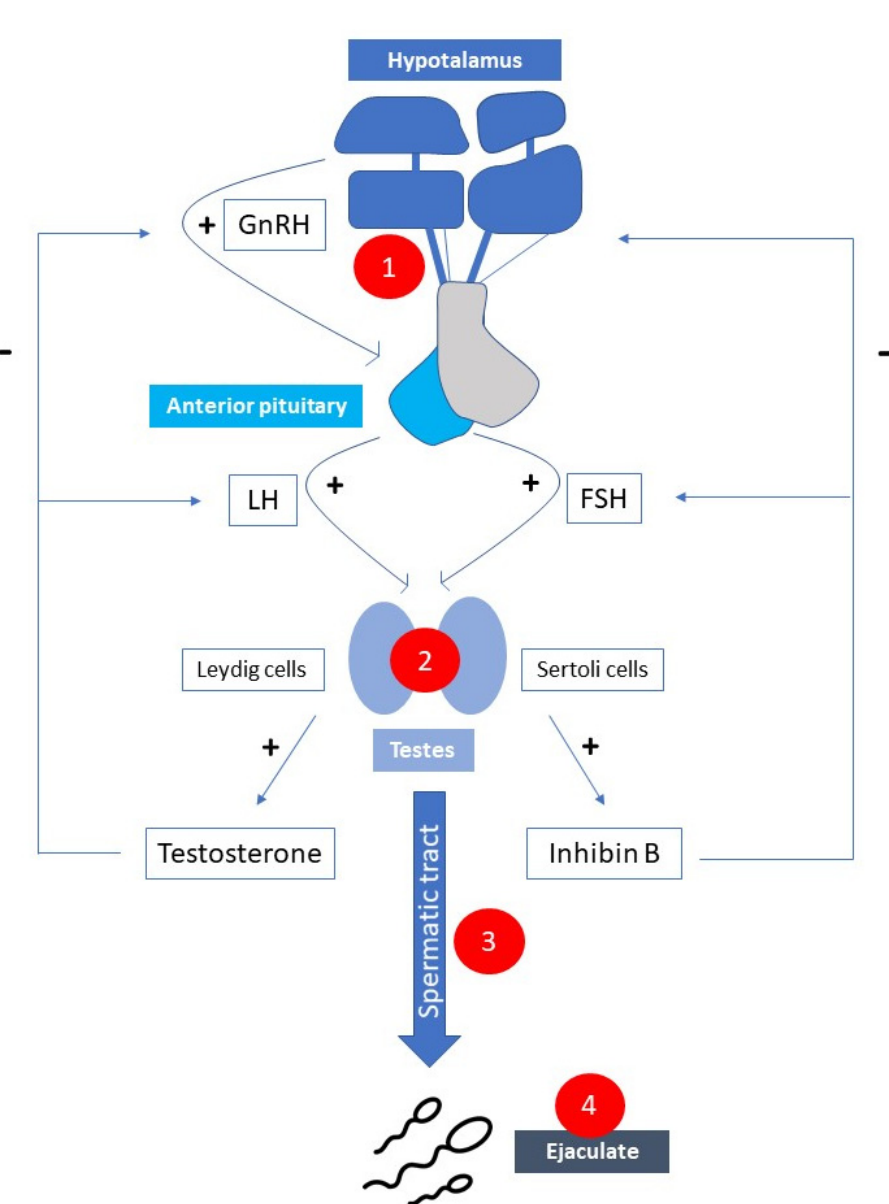
Figure 1. Possible causes of male subfertility correlated with multiple sclerosis. 1. Hypogonadotropic hypogonadism; 2. Hypergonadotropic hypogonadism; 3. Chronic inflammation and/or oxidative stress; 4. Erection/ejaculation dysfunction. (GnRH—gonatropin-releasing hormone; FSH—follicle stimulation hormone; LH—luteinizing hormone).